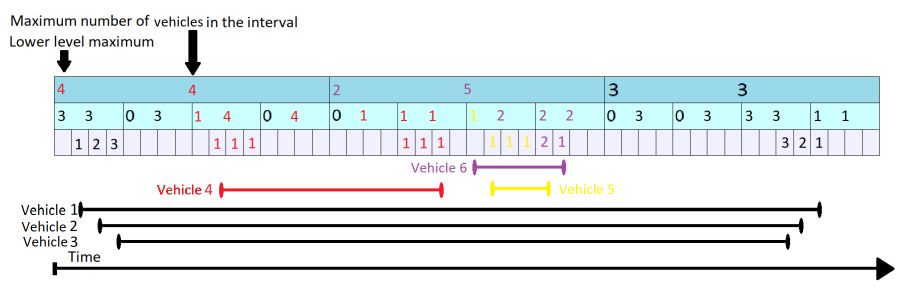
Figure 10. KI Tree Update for Vehicle